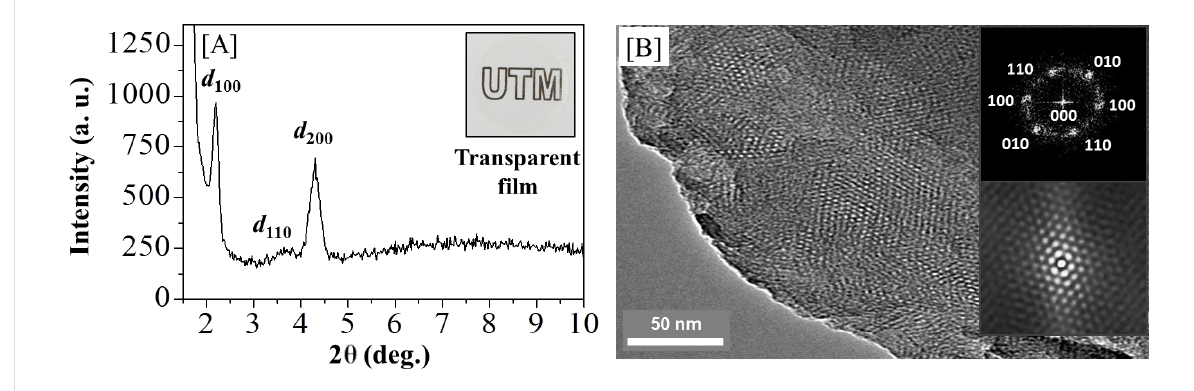
Figure 3: a) XRD diffractogram; the inset is a photograph of the material. b) TEM image; the inset shows the FFT (top) and auto-correlation images (bottom) of [Au 3 Pz 3 ] C10TEG /silica hex .